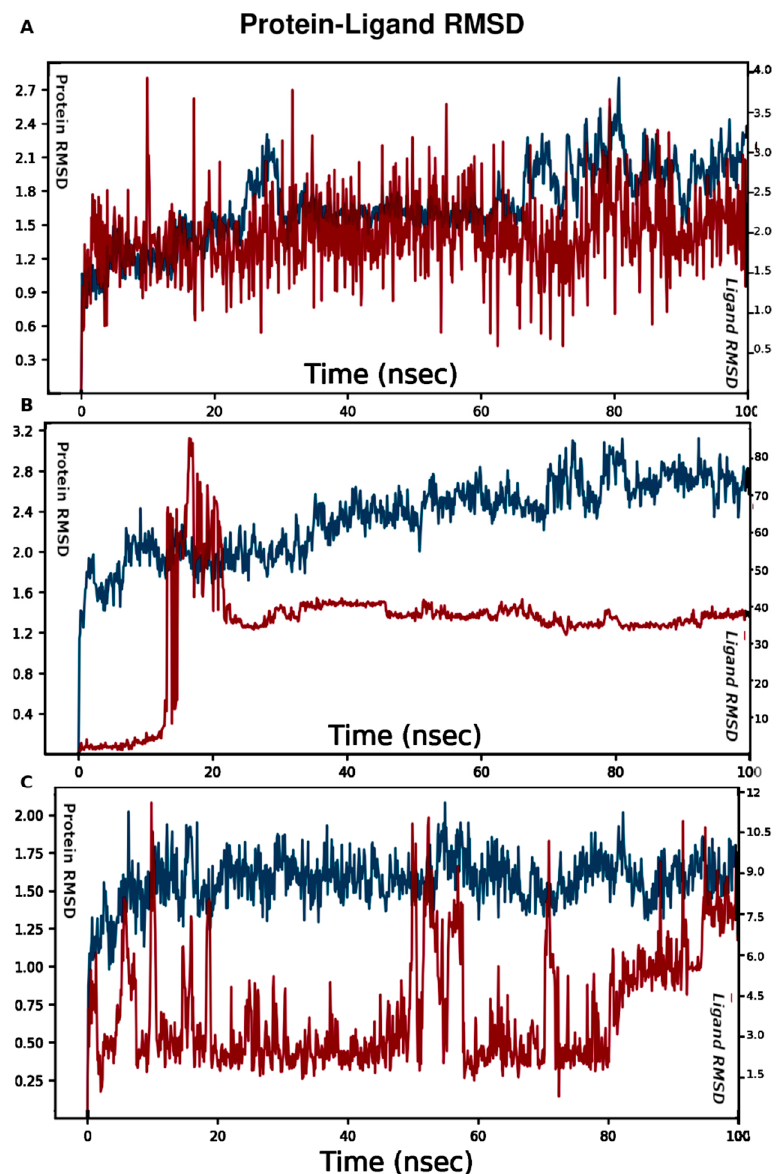
Figure 4. RMSD of emodin pose in site 1 ( A ), site 2 ( B ), and site 3 ( C ). The left Y axis is for protein RMSD, and the right scale is for ligand RMSD. How stable a ligand is in relation to a protein and its binding pocket is shown by the ligand RMSD (right Y-axis). Red for the protein backbone and blue for the ligand RMSD. MD simulations time in ns (X-axis).